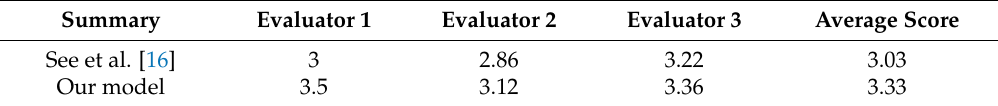
Table 6. Saliency evaluation results. See et al. [16] is the summary generated by the model of See et al. [16] and our model is the summary generated by our model.